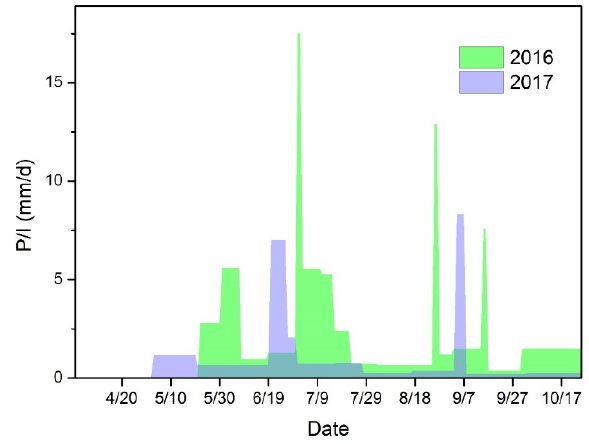
Figure 5. Precipitation interval ratio (P/I) during the growing season in different precipitation years. P/I indicates precipitation interval ratio (mm/d).